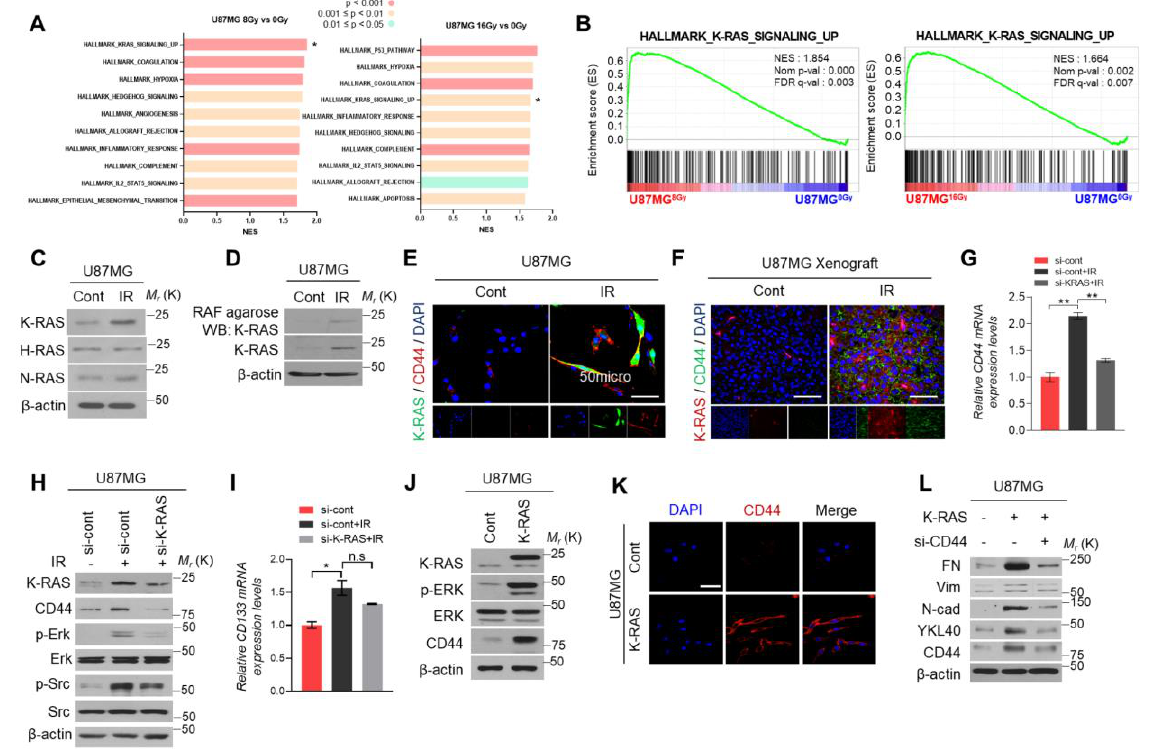
Figure 2. Radiation-induced K-RAS enhances CD44 expression in GBM. ( A ). GSEA analysis of hallmarks of irradiated-GBM cells using the data from GSE56937. ( B ). GSEA analysis indicated that irradiation treated U87MG cells positively correlated with K-RAS signaling pathway. ( C ). Western blot analysis of the expression of the members of RAS family. ( D ). Active K-RAS was measured by a Raf pull-down assay from irradiation treated or non-treated U87MG GBM cells. ( E , F ). Representative ICC staining images of K-RAS and CD44 expression in U87MG cells and mice tissues. ( G , H ). qRT-PCR and western blot analysis of CD44 expression using the ionizing radiation treated-U87MG cells with or without knocked down K-RAS expression. ( I ). qRT-PCR of CD133 expression using the ionizing radiation treated-U87MG cells with or without knocked down K-RAS expression. ( J , K ). Western blot analysis and ICC staining assay for checking the CD44 expression after overexpression of K-RAS in U87MG GBM cells. ( L ). Western blot analysis was performed to check the EMT signature genes expression in K-RAS-overexpressing U87MG cells with or without CD44 expression. β-actin was used as a control for normalization of expression. * p < 0.05, ** p < 0.01, *** p < 0.001, n.s., not significant. A two-tailed Student’s t-test was used to compare data between two groups, and ANOVA was used for multiple comparisons. 2.3. K-RAS/ERK/CD44 Axis Promotes the Invasiveness and Cancer Stemness Features of Irradiated GBM Cells Next, to explore the effects of K-RAS on the infiltration of irradiation treated GBM cells, we performed the invasion assay and showed that the number of invasive cells was increased with the treatment of ionizing radiation and decreased after blocking the K-RAS expression with si-RNA (Figure 3A). Similarly, the FACS analysis also showed that radiation treatment enhanced the percentage of CD44 + /CD24 − cells number, while it decreased with silenced the K-RAS expression in both U87MG and U251MG cells (Figure 3B and Supplementary Figure S1A). Moreover, the sphere formation assay showed that the IR-induced increases of sphere numbers were suppressed by blocking the K-RAS expression in U87MG cells (Figure 3C). Additionally, the expression of mesenchymal markers was also inhibited by silencing the K-RAS expression using qRT-PCR and western blot analysis (Figure 3D , E). These findings showed that the K-RAS is the main factor in regulating the radiation-induced CD44 expression and invasiveness in GBM. As reported, various different signal transduction pathways can be activated by RAS activation. Among these pathways, the MAPK (Mitogen-activated proteins kinase) is the best-studied pathway, which has known as a RAS major effector pathway and plays a key role in survival, drug resistance, and metastasis of cancer [15–17]. Previous studies